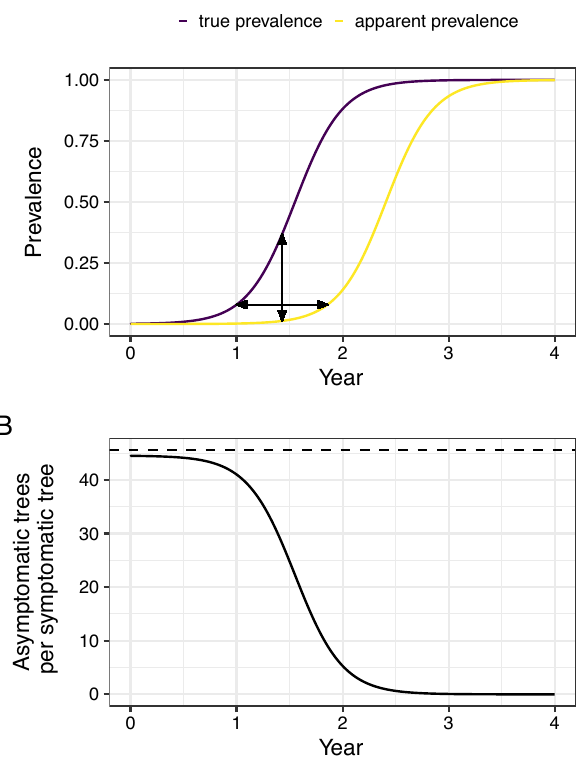
Figure 1. The true prevalence of infection can be estimated for any apparent prevalence from the rate of pathogen spread and the length of the detection lag period. ( A ) A detection lag period can be considered as a shift of the epidemic growth curve to the right. In this plot, time is shown on the x-axis and the proportion of infected or symptomatic hosts (the prevalence) on the y-axis. The two curves represent the true prevalence and the apparent prevalence (e.g. the proportion of hosts with symptoms, if detection is based upon visual inspection). The curves are parameterised based upon X. fastidiosa , but are intended for visualising the relative difference in true and apparent prevalences rather than the exact prevalences at different time points. The horizontal distance between the curves (i.e. in the direction of the x-axis) represents the asymptomatic period (the detection lag (δ) for visual inspection), and the vertical distance (in the direction of the y-axis) represents the difference between the true and apparent prevalences at any given time. ( B ) The ratio of the true and apparent prevalences decreases as the true prevalence increases. This plot shows the ratio of the true and apparent (detectable) prevalences (which can be interpreted as the number of asymptomatic trees per symptomatic tree) under logistic and exponential growth as time progresses. The dashed line represents the predicted ratio under continued exponential growth and the solid line represents that under logistic growth. Although during very early stage spread, the growth in both the true and apparent prevalences is broadly exponential, as the true prevalence deviates from this, the ratio of the two prevalences starts to